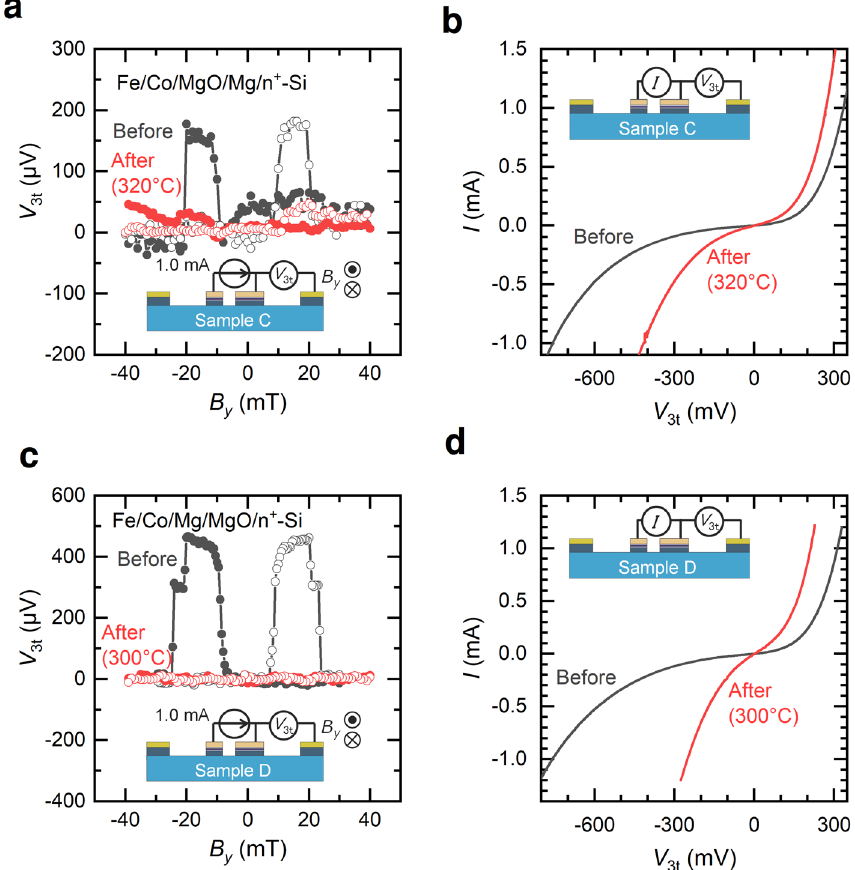
Figure 7. Results of the L3T measurements and I – V measurements of samples C and D. L ch = 2.75 µm, t = 100 nm for both samples. The widths of F1 and F2 were 0.5 and 2.0 µm, respectively. ( a ) Results of the L3T measurements of sample C. Black and red plots show the results before and after annealing, respectively. ( b ) Results of the I – V measurements of sample C. Black and red plots show the results before and after annealing, respectively. ( c ) Results of the L3T measurements of sample D. Black and red plots show the results before and after annealing, respectively. ( d ) Results of the I–V measurements of sample D. Black and red plots show the results before and after annealing,